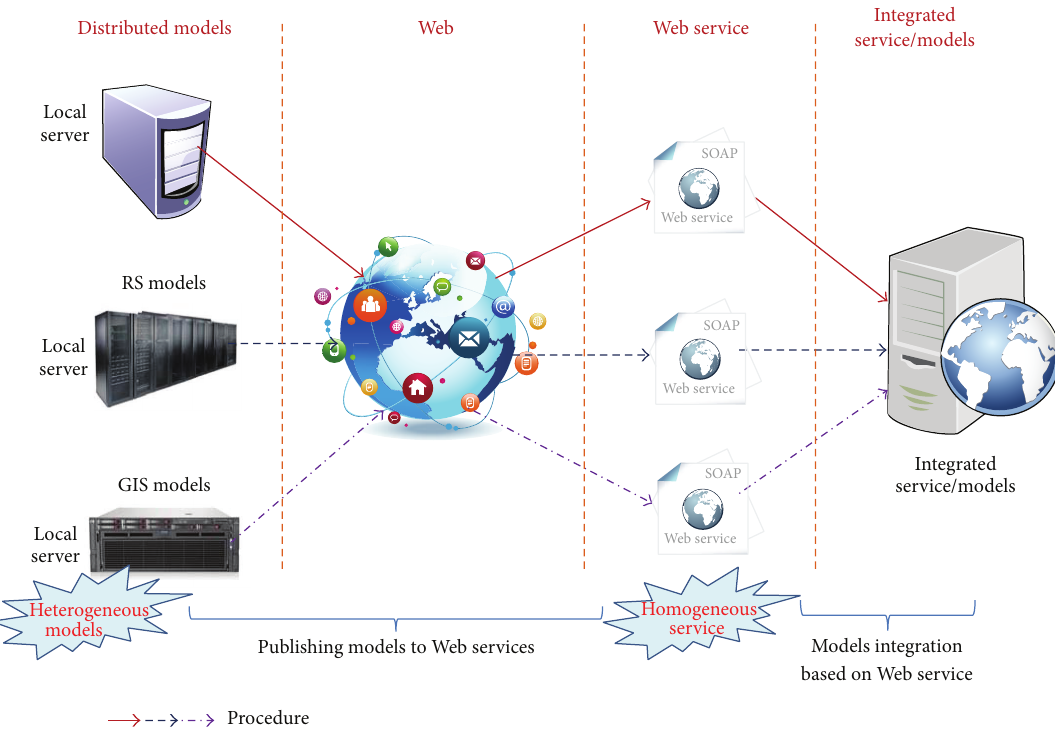
Figure 1: The framework of GIS and RS model sharing and integration based on Web service.